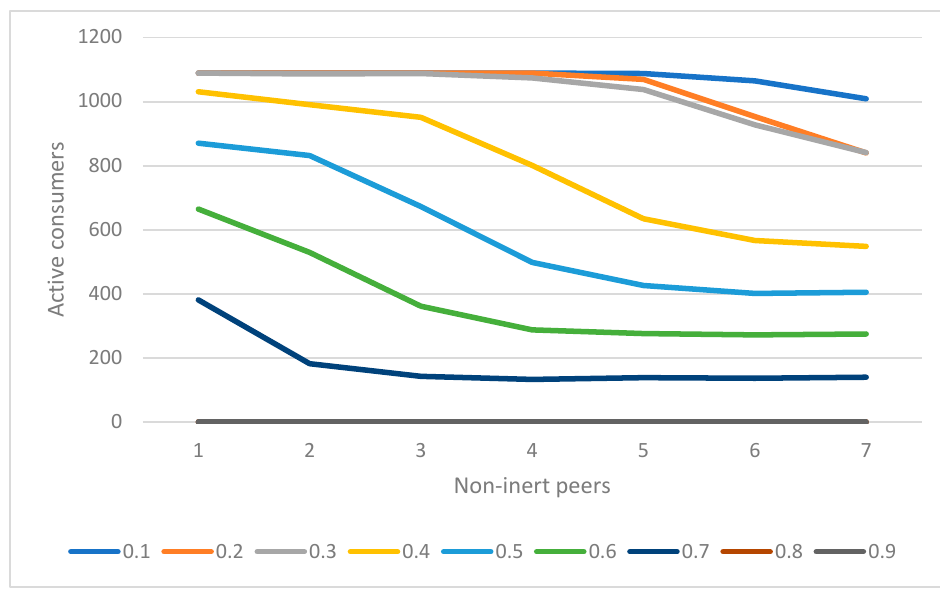
Figure 6. Consumer activity at low influence.